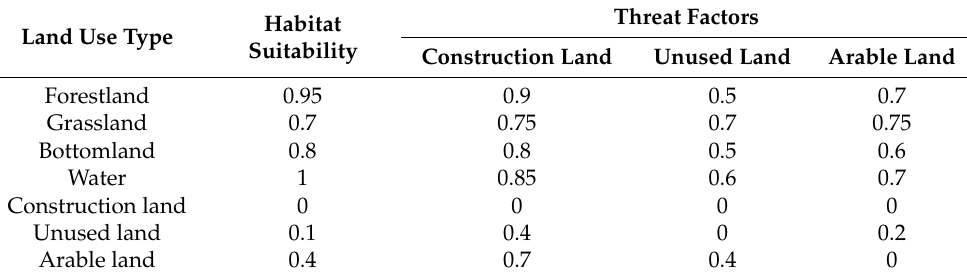
Table 5. Sensitivity of land-cover types to threat